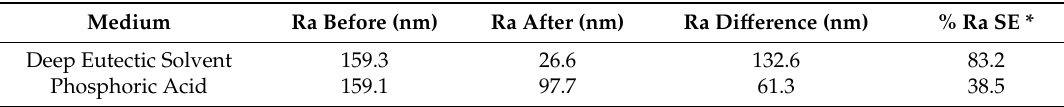
Table 2. Roughness average (Ra) in nm for each metal post and prior to treatment with the respective solutions noted at 70 °C for 900 s. Calculated differences determined % smoothing efficiency (SE) for each sample.